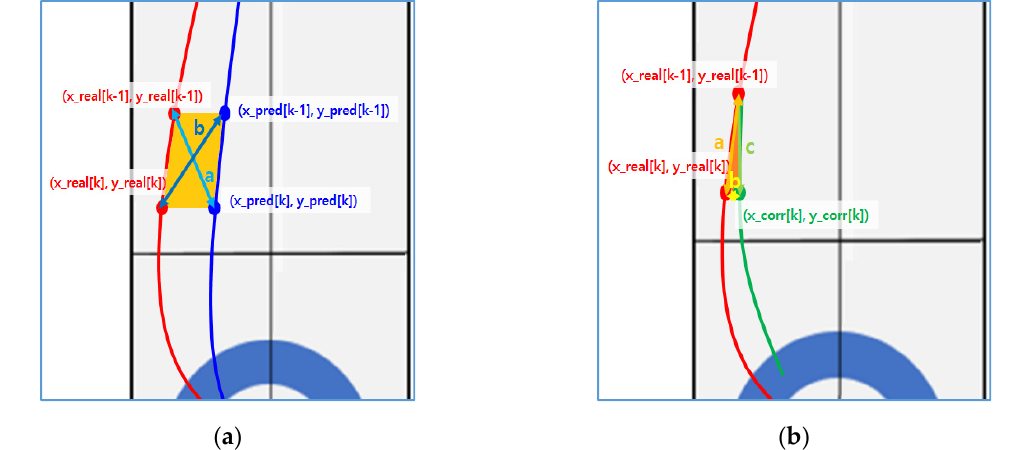
Figure 5. ( a ) Return path generation using proportional area. ( b ) Area changed after path